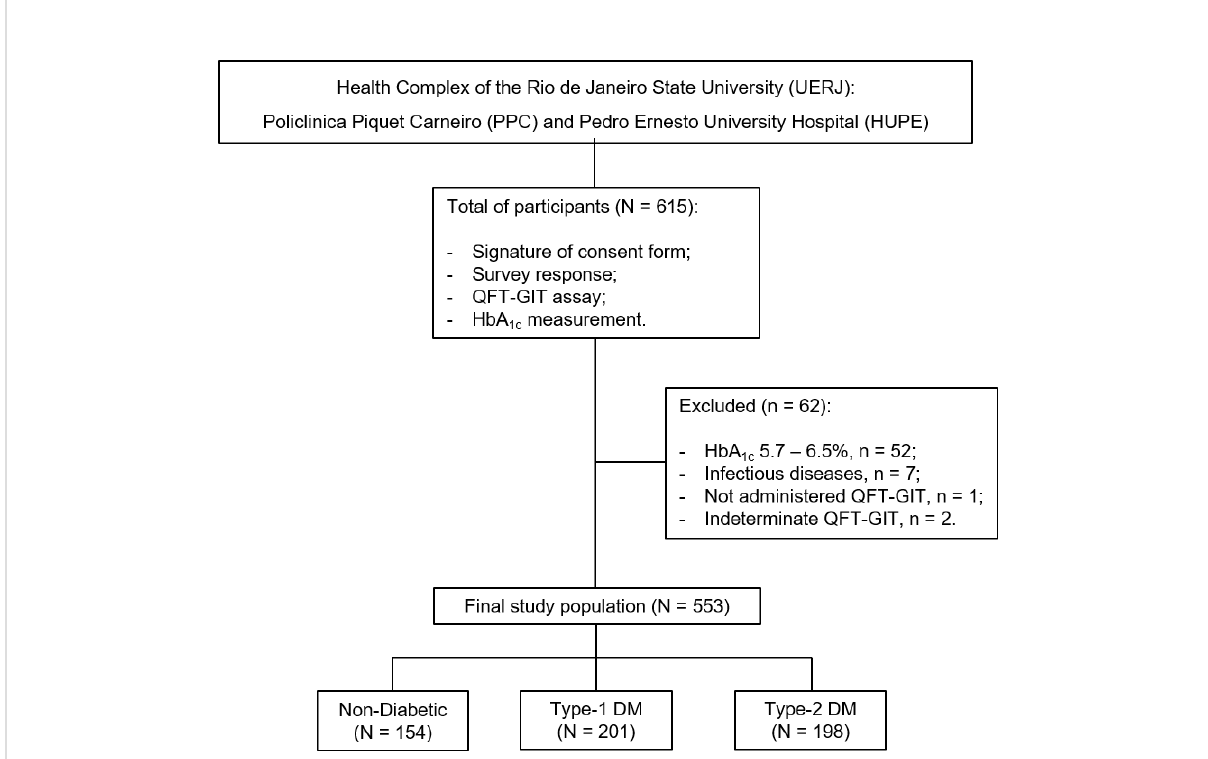
FIGURE 1 Flow chart of the study design. A total of 615 individuals were recruited for the study. Of these, 553 represented the fi nal study population based on the eligible criteria and were categorized as follow, non-DM subjects (N = 154), type-1 DM (N = 201) and type-2 DM (N = 198). DM, diabetes mellitus; HbA 1c , glycosylated hemoglobin; QFT-GIT, QuantiFERON-TB Gold in Tube; n, sample